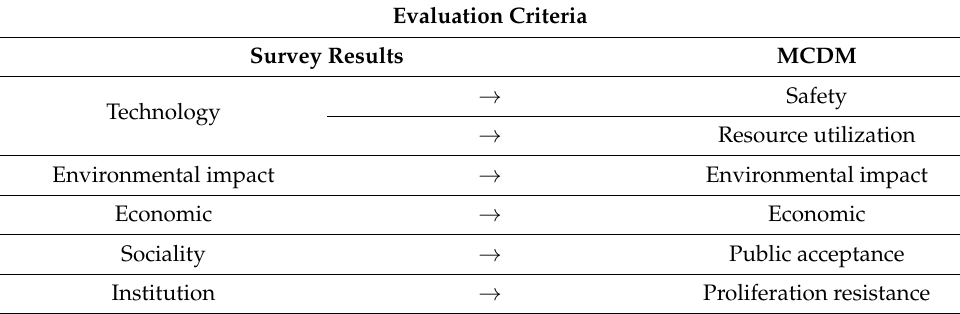
Table 1. Evaluation criteria of the multi-criteria decision making (MCDM)